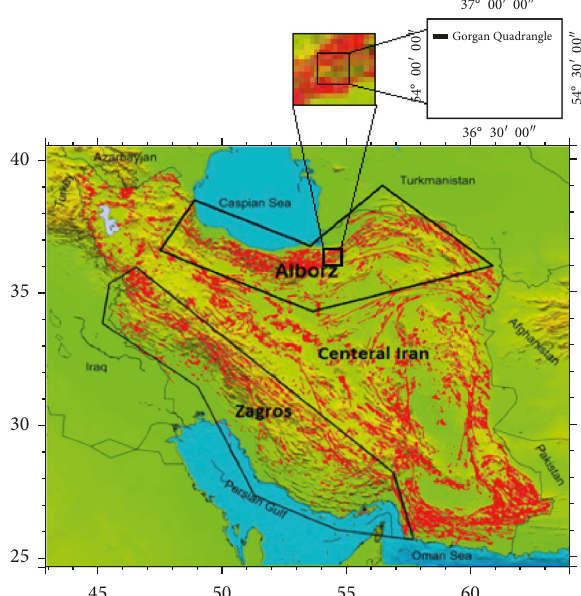
Figure 2: Iran could be divided into two regions: Zagros region and Alborz and Central Iran region (the remaining area of Iran) [26,